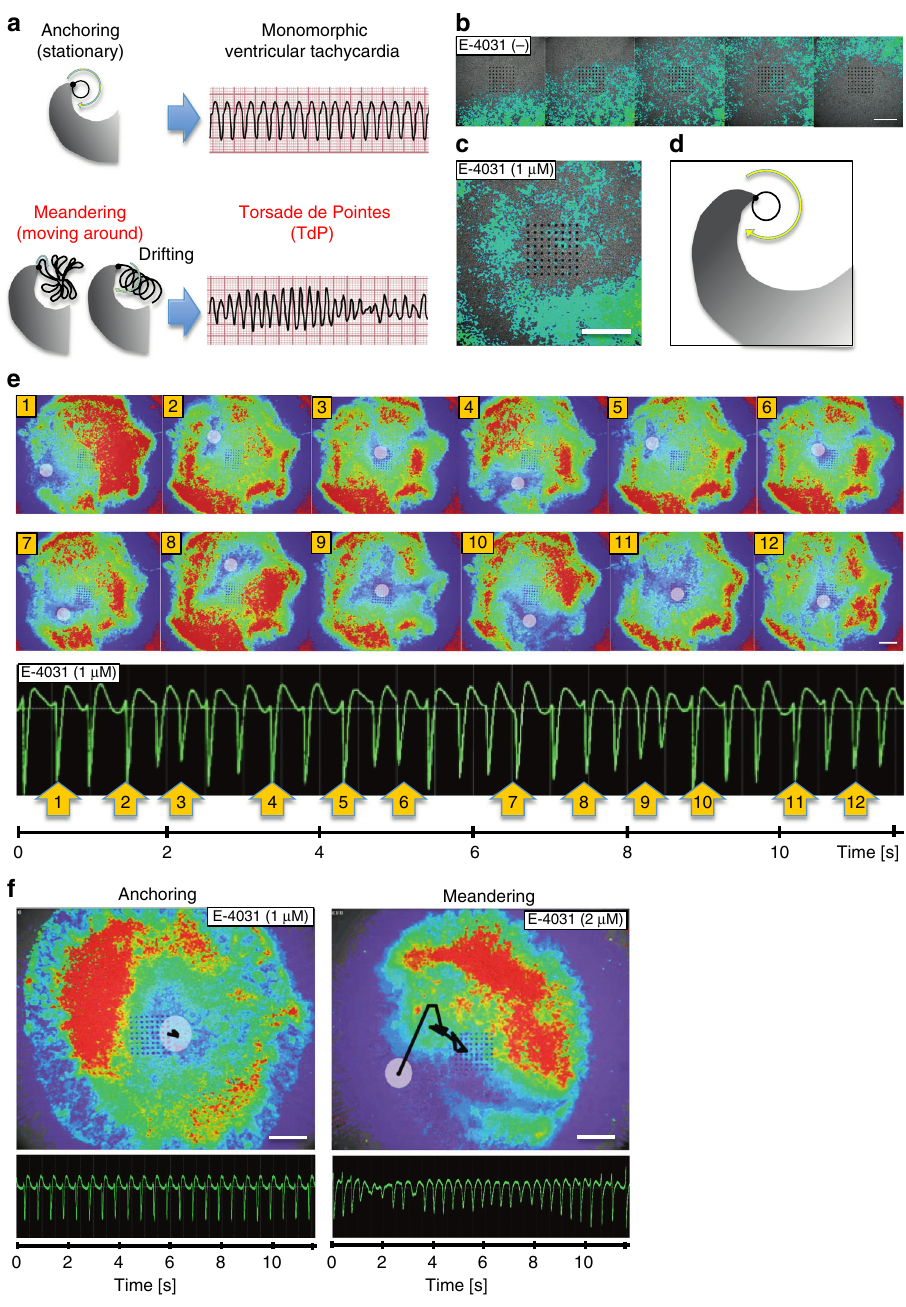
Fig. 3 Drug-induced TdP in CTSs visualized by Motion Vector Prediction. a Schematic images of two re-entrant arrhythmia patterns for the spiral wave re-entry theory. Anchoring pattern and Meandering pattern. b Representative normal beats visualized by motion vector prediction (captured from Supplementary Movie 3). Unidirectional biphasic wave propagation (E-4031, 0 nM). c Representative anchoring spiral wave re-entry visualized by motion vector prediction (captured from Supplementary Movie 4). Anchoring spiral wave re-entry motion propagation (E-4031, 1 μ M). d Schematic image related to c . e Representative meandering spiral wave re-entry with simultaneous recording of EFP and cell motion (E-4031, 1 μ M). Cell motion is visualized by motion vector prediction (captured from Supplementary Movie 6). White circles: spiral wave center. EFP shows TdP-like waveform. The numbers in the upper and lower panels indicate the same time points. Note that similar spiral wave center movement (ex: 2 to 3 and 5 to 6) causes similar EFP polymorphisms. f Tracing of the spiral wave centers. Representative anchoring of spiral wave re-entry with the corresponding monomorphic ventricular tachycardia-like EFP waveform (E-4031, 1 μ M) and representative meandering (drifting) of spiral wave re-entry (upper) with the corresponding TdP-like EFP waveform (E-4031, 2 μ M). White circles: center of spiral wave. Black lines: trace of the center. Scale bars: 1 imaging system (Motion Vector Prediction; Sony, Tokyo, Japan) successfully detected the appearance of both spiral wave re-entry that captures the magnitude of beating cell motion (contraction patterns. Before E-4031 treatment, we con fi rmed unidirectional and relaxation) as biphasic waves (Supplementary Fig. 7) and biphasic wave propagation with simple contraction-relaxation visualized computed 2D images of the projection map. We movements of synchronized beating (Fig. 3b and Supplementary simultaneously recorded EFP and cell motion imaging and Movie 3). After E-4031 treatment, we observed spiral wave